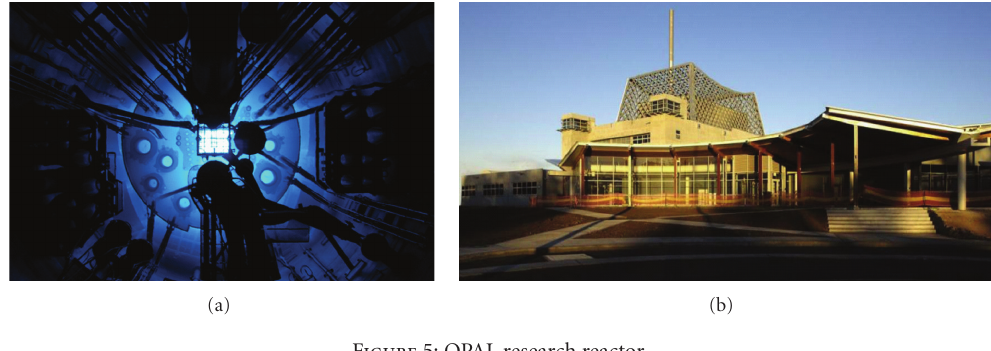
Figure 5: OPAL research reactor.